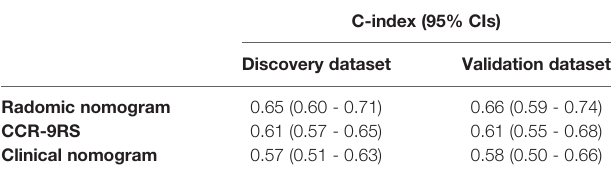
TABLE 3 | Performances of different models.